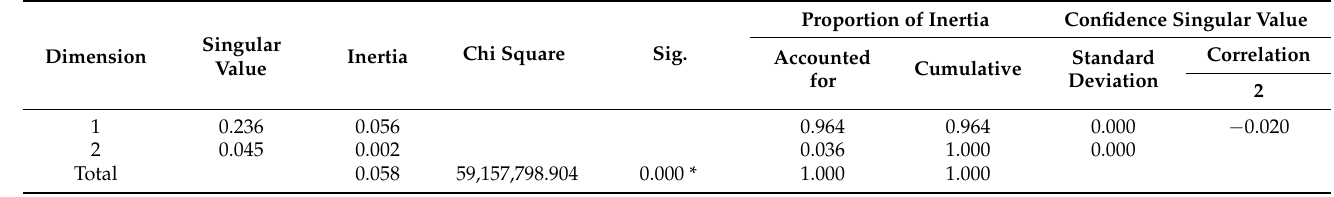
Table A1. Summary of correspondence. Positioning and source of web traffic.